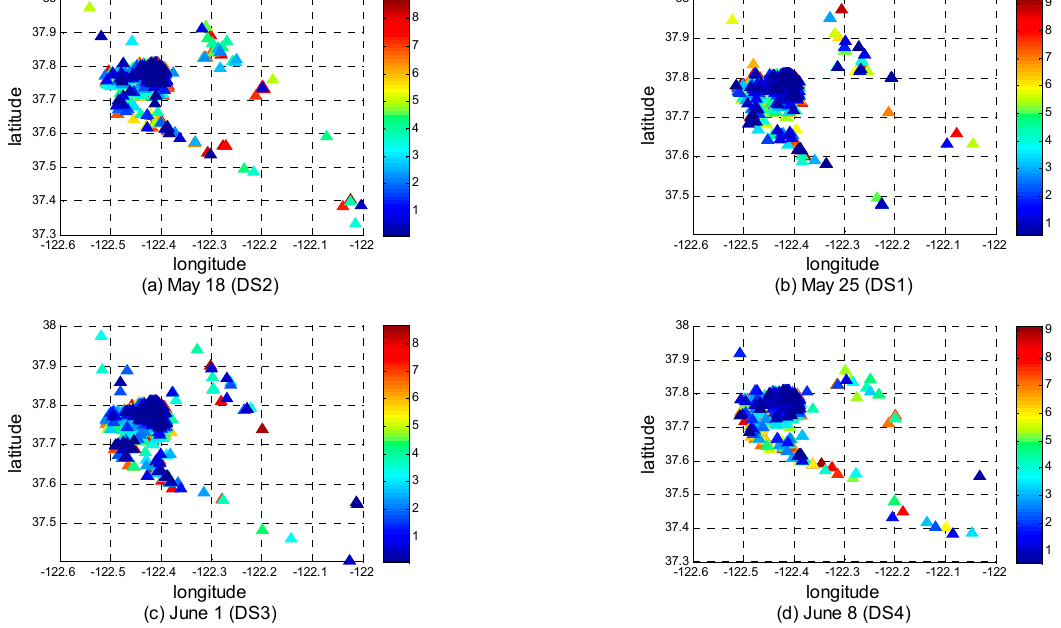
Figure 11. The time-sequential coloring graph of optimal stay centers. The DBSCAN clustering method is used for datasets DS1 – DS4 .